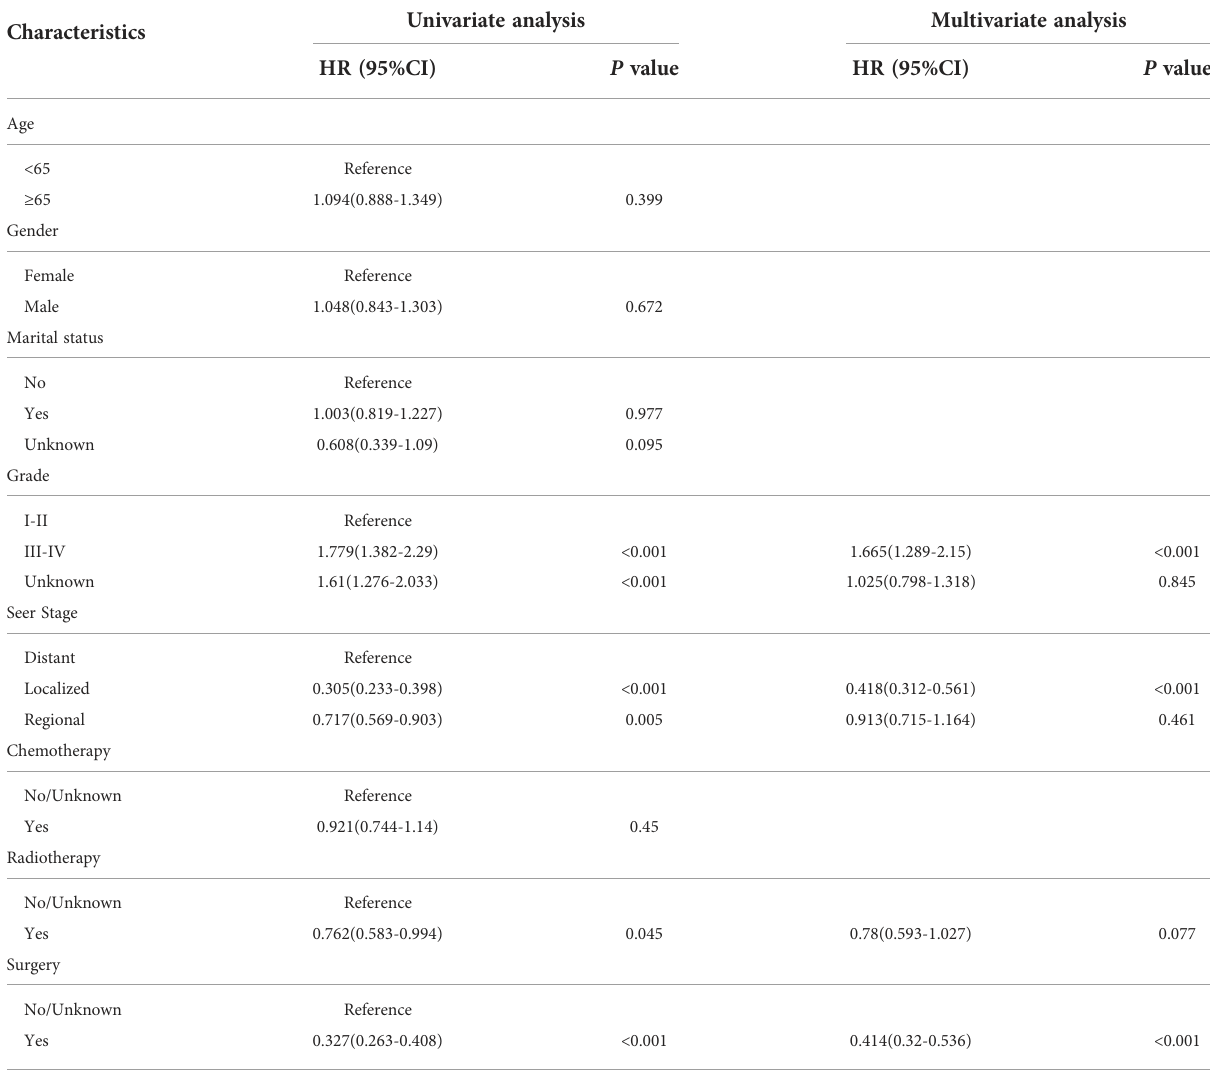
TABLE 3 Univariate and multivariate Cox regression analysis of CSS in training